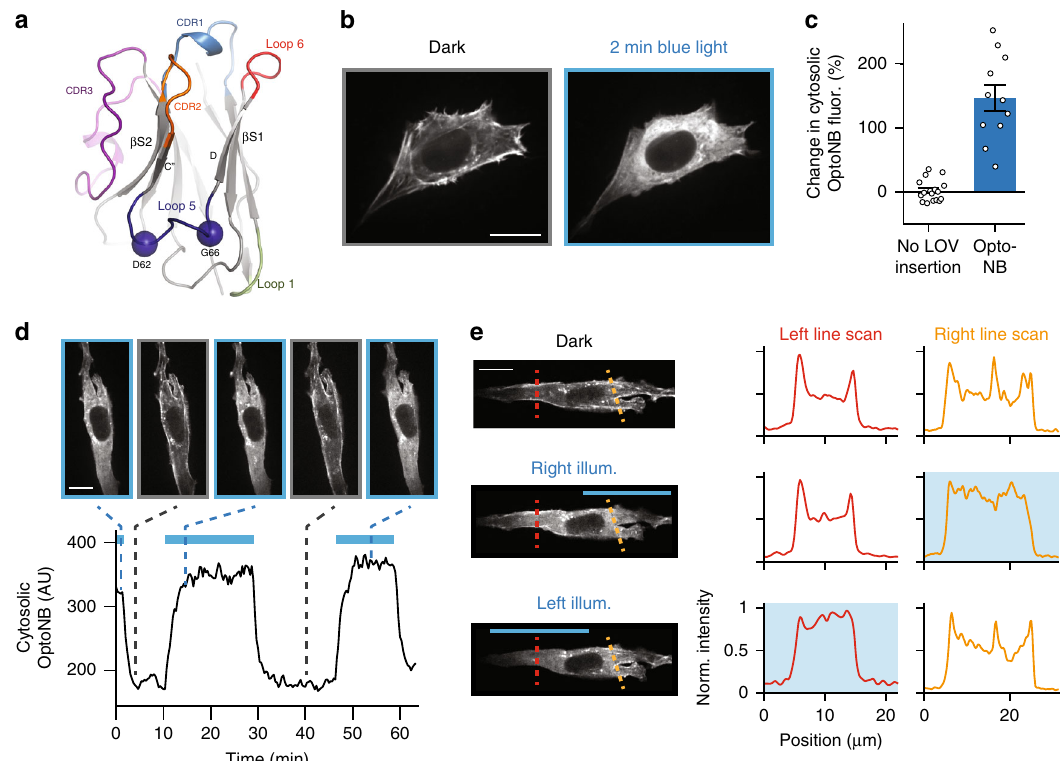
Fig. 5 Development and characterization of an anti-actin OptoNB. a Position DG62-66 targeted for the LOV domain insertion into the α -actin nanobody and mapped onto the crystal structure of the anti-GFP minimizer nanobody (PDB ID: 3G9A). Residues D62 and G66 (blue spheres) are highlighted within Loop 5 (dark blue). CDRs, Loop 1, and Loop 6 are colored as previously described in Fig. 1. b Still frames showing dark and illuminated conditions for a cell expressing the actin OptoNB fused to TagRFP. c Light-induced translocation of actin OptoNBs. The light-induced change in cytosolic intensity from the original, dark-equilibrated value is shown. Error bars indicate means ± SEM for n = 17 and 11 cells, respectively. d Reversible actin OptoNB translocation to and from the cytoskeleton in a representative cell. Curve indicates the mean intensity in a cytosolic region in response to pulses of blue light (blue bars). Upper images show the cell at the indicated time points. e Spatial illumination leads to local nanobody unbinding. Left panels: representative images of a representative cell that was left un-illuminated or illuminated for 10 min on its left or right half. Dashed lines indicate positions of line scans for quantifying local enrichment along actin fi laments. Right panels: quanti fi cation of actin OptoNB fl uorescence along the line scans in dark, left, or right illumination. Scale bars: 20 μ m. Source data are available as a Source data fi